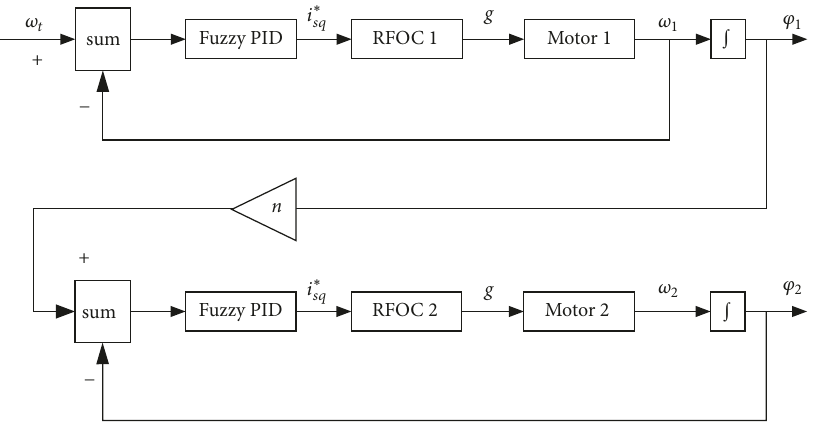
Figure 2: Flow diagram of the controlled